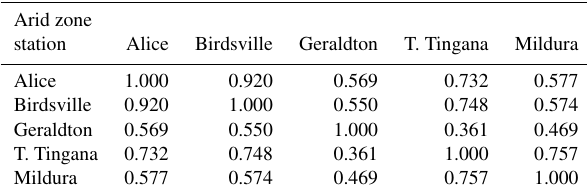
Table 5. Pearson’s correlation coefficient between all arid zone sta- tion pairs, for stations with time series of 60 months or